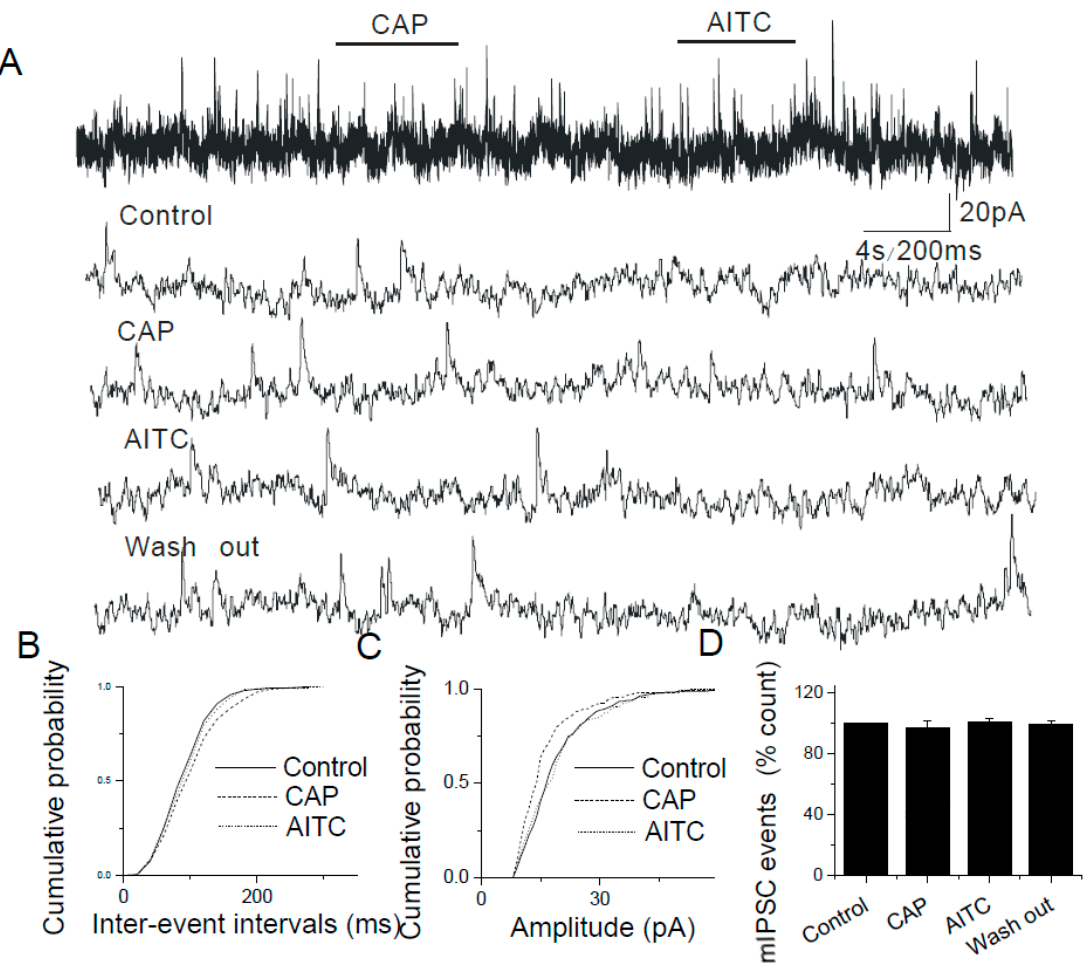
Figure 8. AITC does not alter inhibitory synaptic transmission in the NTS. ( A ) Administration of AITC (500 µ M) or capsaicin (i.e., CAP; 200 nM) did not have any e ff ect on the frequency of mIPSCs (top trace). Bottom four traces: the same synaptic events are shown at a higher time resolution. ( B , C ) The cumulative probability plots show no significant changes ( p < 0.0001, KS test) in the distributions of inter-event intervals ( B ) and amplitudes ( C ) of mIPSCs. ( D ) A summary graph illustrating a lack of e ff ects of AITC on the mIPSC frequency ( n = 10).